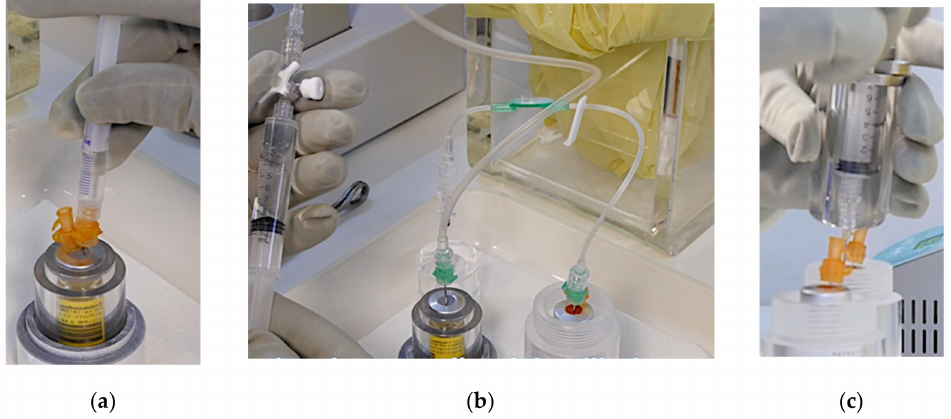
Figure 4. [ 177 Lu]Lu-DOTA-TOC and [ 90 Y]Y-DOTATOC synthesis ( a ), dilution and sterilization ( b ) and manual fractionation ( c